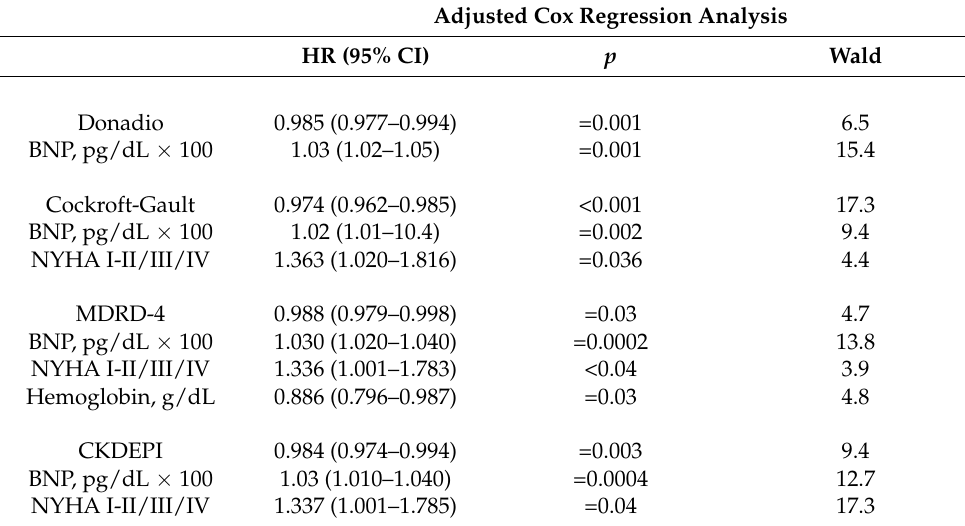
Table 4. Multivariate Cox proportional hazards survival